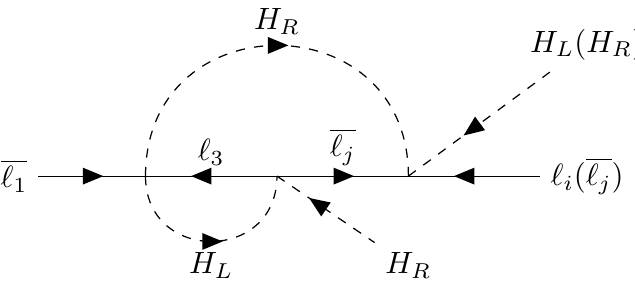
Figure 6 . Radiative corrections to y i 1 and M 1 j (parenthesis) in the EFT. Loop momenta near the EFT cutoff scale lead to (6.9) and